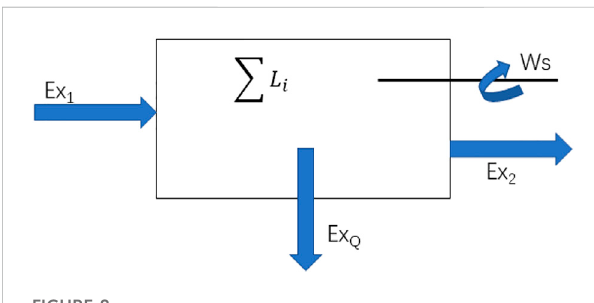
FIGURE 8 Schematic diagram of steady-state steady fl ow control body exergy balance